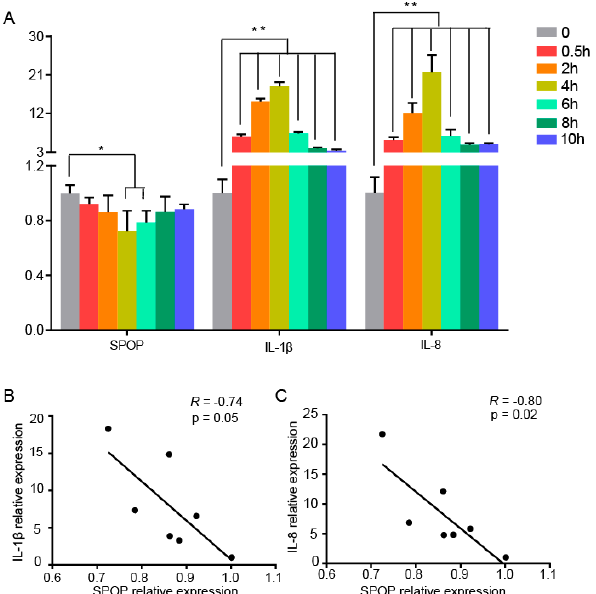
Figure 1. Speckle-type POZ (poxvirus and zinc finger) protein (SPOP) participated in the negative regulation of the immune response in cells. ( A ) HD11 cells were stimulated with lipopolysaccharide (LPS) for the indicated times. The cells were then harvested for RNA extraction. IL-1 β , IL-8, and SPOP expression was measured using quantitative real-time polymerase chain reaction (qRT-PCR). Data were shown as means ± SD. * p < 0.05; ** p < 0.01 ( B , C ) Correlations between SPOP and IL-1 β or IL-8 expression were analyzed using GraphPad